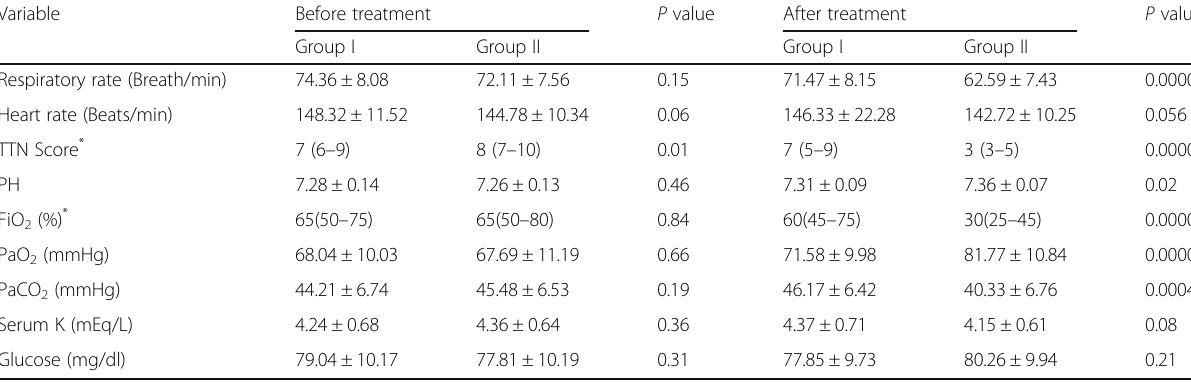
Table 4 Comparison between group I and group II before and 4 h after treatment Variable Before treatment P